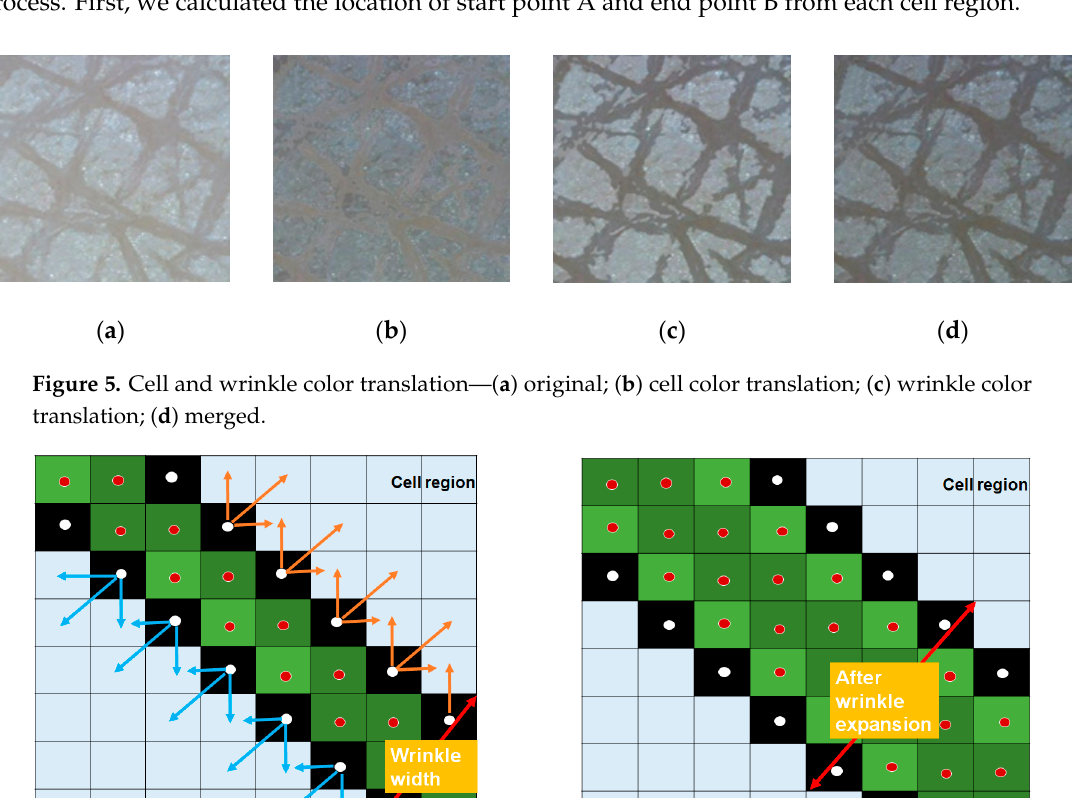
Figure 5. Cell and wrinkle color translation—( a ) original; ( b ) cell color translation; ( c ) wrinkle color translation; ( d ) merged.